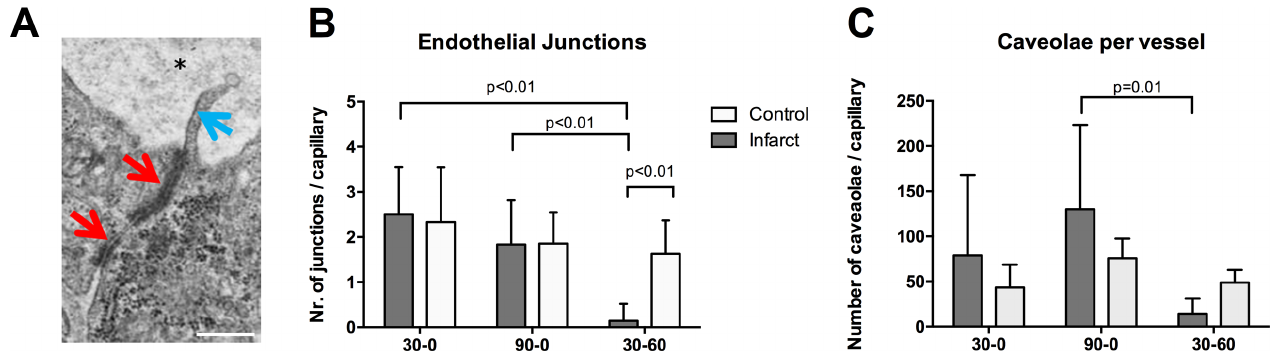
Fig 7. Endothelial junctions and caveolae. Quantification of endothelial cell-cell junctions. A Typical TEM image of a part of two endothelial cells with cell-cell junctions (red arrows). Protruding into the lumen of the capillary (asterisk) marginal fold can be seen (blue arrow). White bar represents 100 nanometer. Magnification 17500x. B Quantitative analysis showing the mean number of cell-cell junctions per capillary in the infarct zones in all three groups. C Mean number of endothelial caveolae per capillary, as determined with transmission electron microscopy.